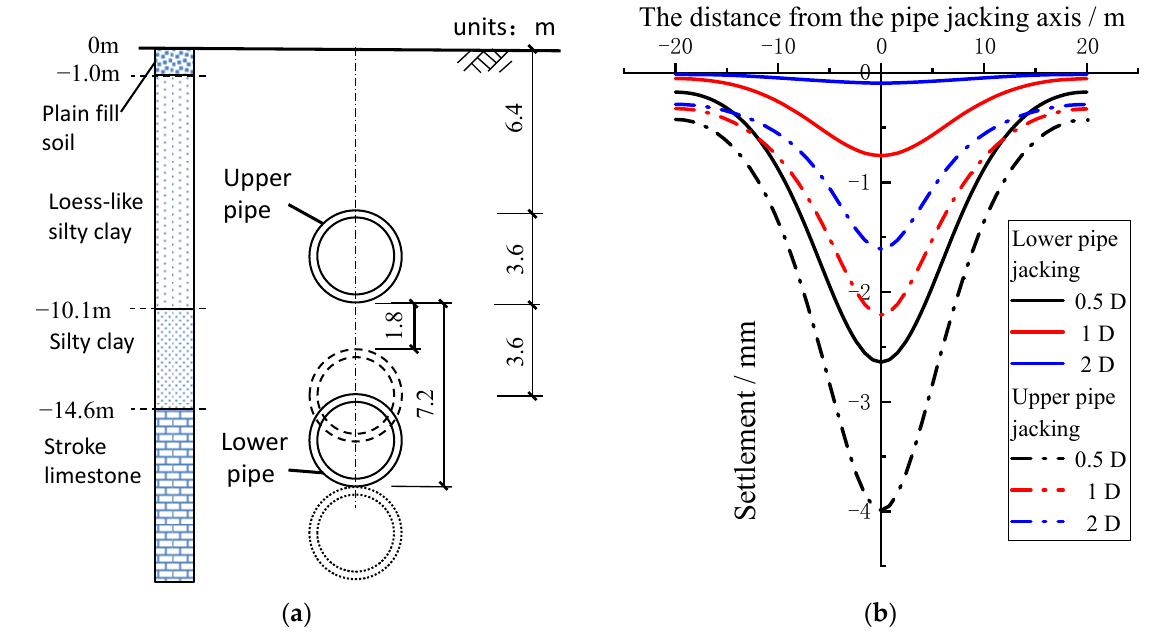
12 of 17 Figure 11. Comparisons of horizontal lateral displacement produced by pipe jacking. 5.3. Influence Analysis of Vertical Spacing between Pipes Based on the established model, the influence of vertical clear spacing were explored. The clear spacing between two pipes is 0.5 D and 2 D, respectively (D is the outer diameter of the jacking tube). Figure 12a shows the position of lower pipe jacking when the spacing is changed. Figure 12b shows the comparison of the ground settlement caused by pipe jacking with different vertical spacing. Table 3 shows the value of ground settlement